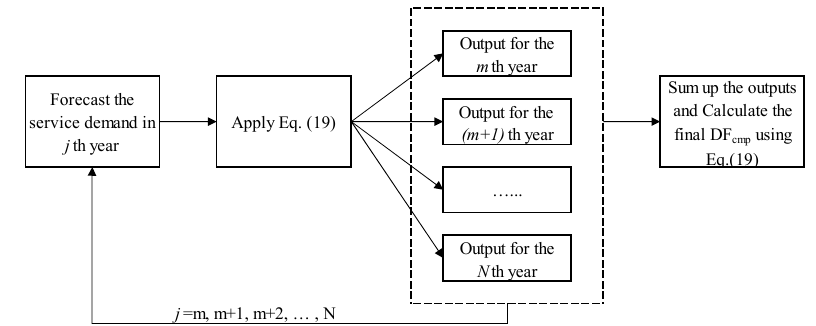
Figure 2. Simulation process for decision factor calculation.